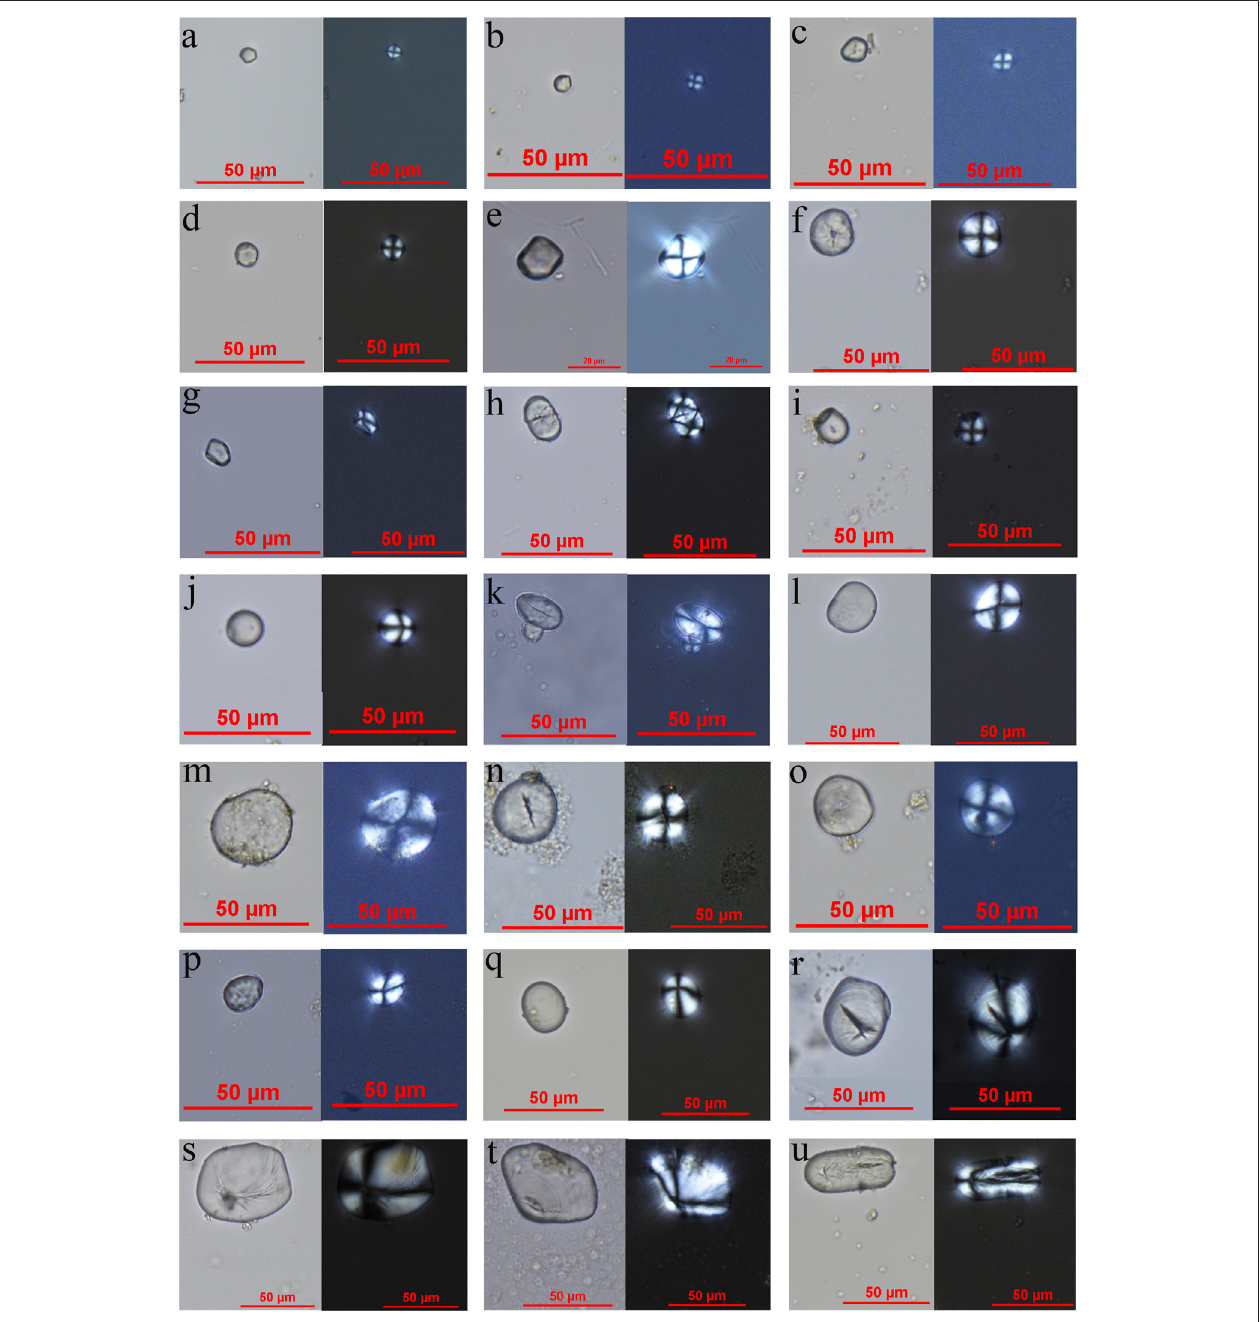
FIGURE 4 | Starch granules from Dingsishan Sed III plant residue samples. (A) Polyhedron starch granule (B) Polyhedron starch granule (C) Polyhedron starch granule (D) Polyhedral spheroid starch granule (E) Polyhedron starch granule (F) Polyhedral spheroid starch granule (G) Polyhedron starch granule (H) Semi-ellipsoid starch granule (I) Bell-shaped starch granule (J) Ellipsoid starch granule (K) Ellipsoid starch granule (L) : Ellipsoid starch granule (M) : Ellipsoid starch granule (N) : Drop- shaped starch granule (O) : Ellipsoid starch granule (P) : Drop-shaped starch granule (Q) : Ellipsoid starch granule (R) : Ellipsoid starch granule (S) : Ellipsoid starch granule (T) : Fan-shaped starch granule (U) : Elongated-ellipsoid starch granule.